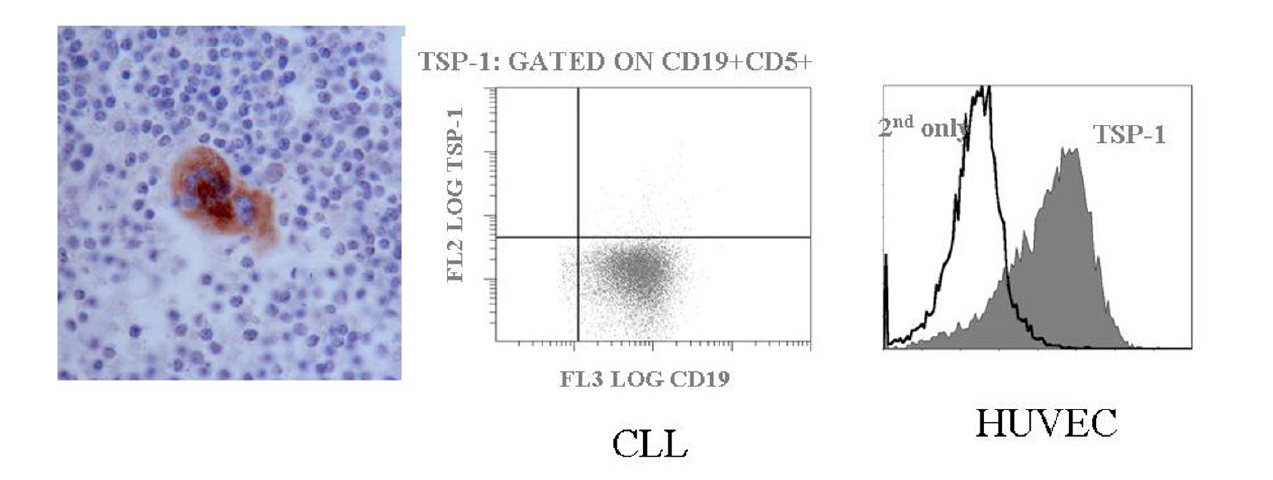
Figure 7 TSP-1 is not expressed by CLL cells . CLL cells in all cases tested for TSP-1 expression by immunohistochemistry were negative. In the left panel is a case of CLL with a field of TSP-1 negative lymphocytes. At the center of this field is an internal positive control, a megakaryocyte. The TSP-negativity of CLL cells was verified by flow cytometry. All 21 cases tested had results similar to the cases illustrated in the middle panel. HUVEC cells, which are known to express TSP-1, were positive by flow cytometry (right